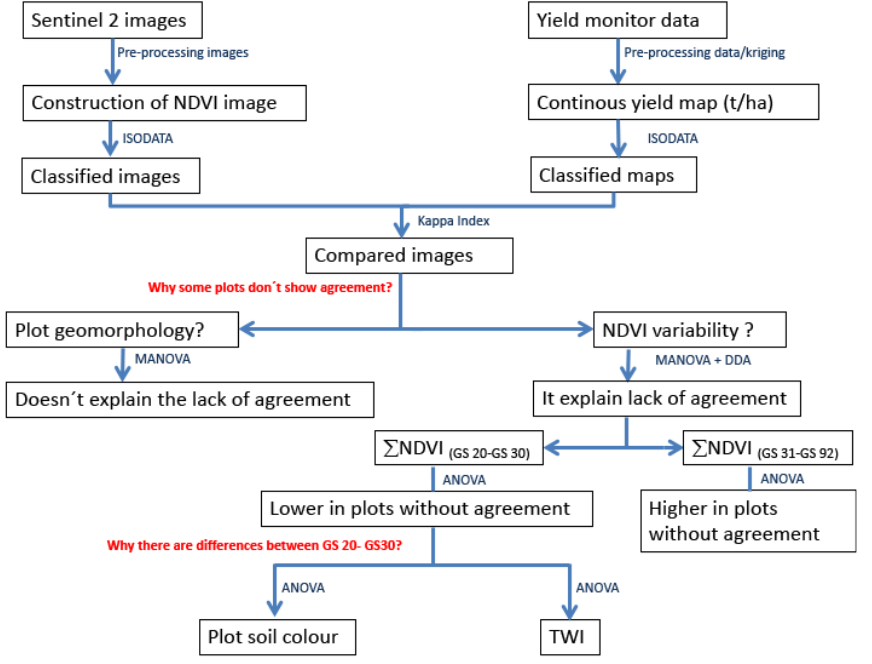
Figure 4. Flowchart of the steps carried out to analyze the data of the study. Out of the boxes, in blue, statistical procedures used are specified. In red are the two critical questions that need to be answered.